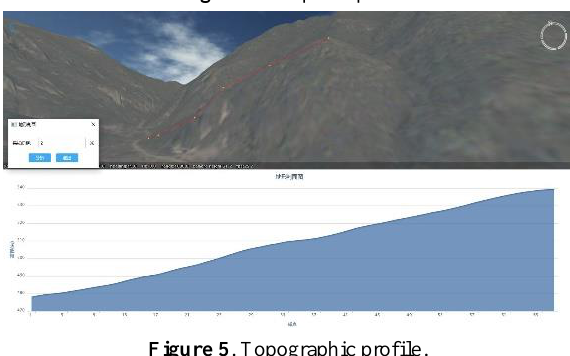
Figure 5 . Topographic